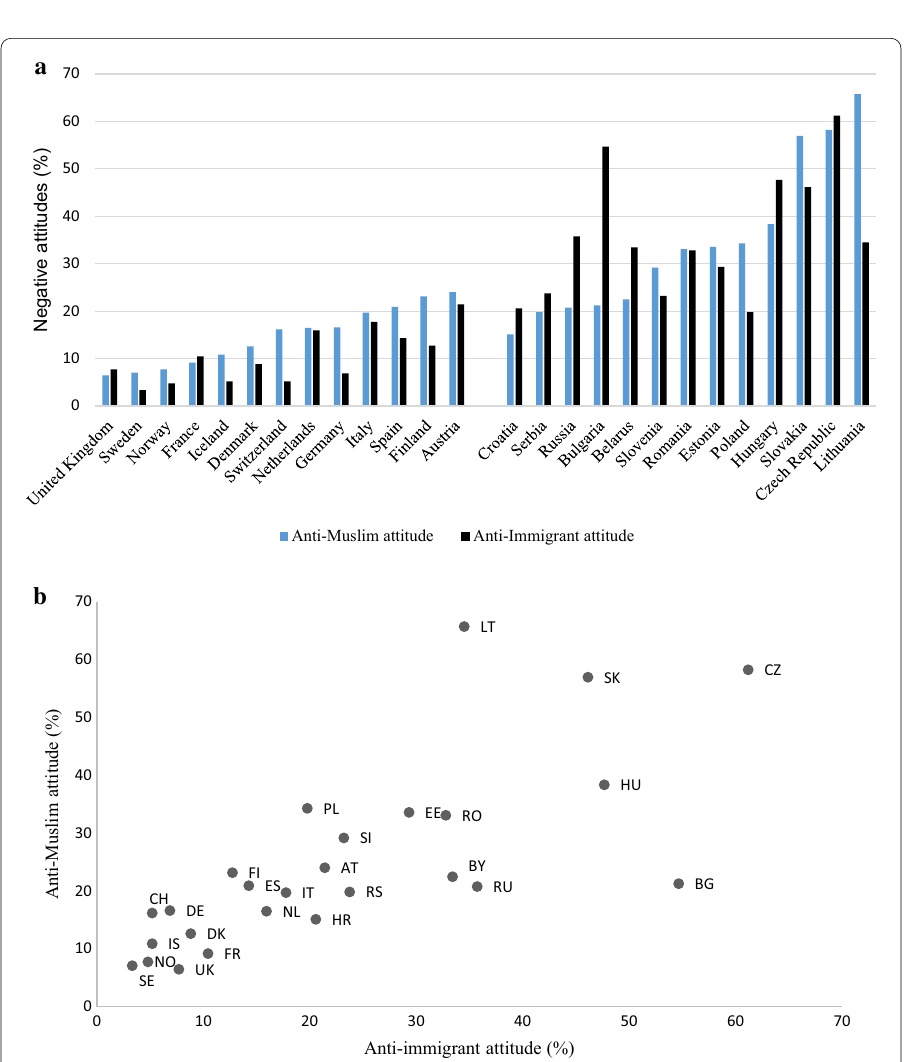
Fig. 3 a Country-specific anti-Muslim and anti-immigrant attitudes in Europe (2017). b Country-specific scatterplot of anti-Muslim and anti-immigrant attitudes in